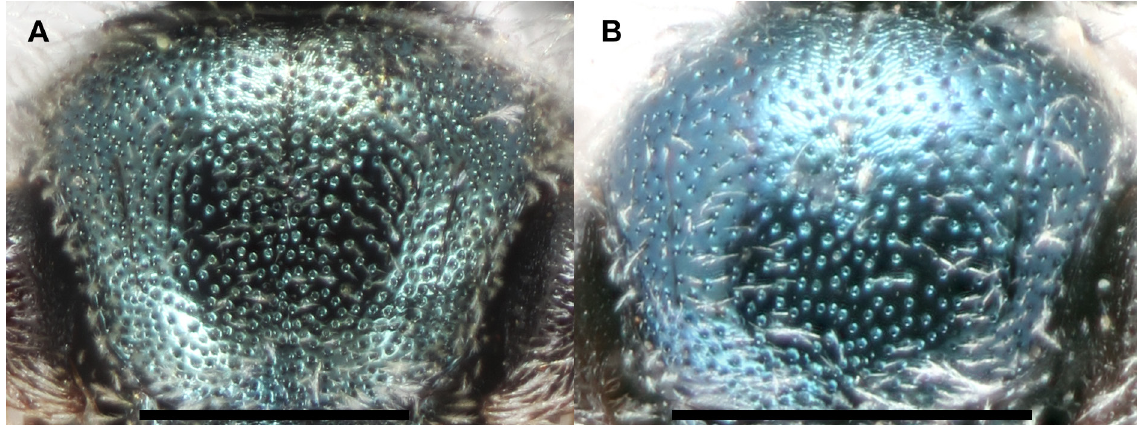
Fig. 108. Mesoscutum. A . Lasioglossum tegulariforme (Crawford, 1907), ♂, densely punctate. B . L. pseudotegulare (Cockerell, 1896), ♂, moderately sparsely punctate. Scale bars = 0.5 mm.